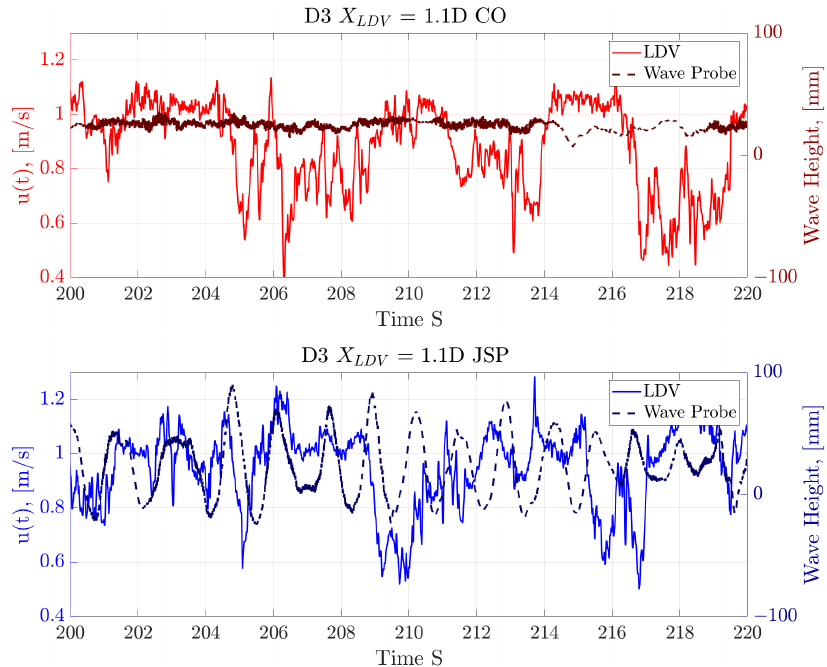
Figure 3. Time series of the stream-wise fluid velocity measured via the LDV and wave height measured via the wave probes. The measurements were made at the rotor plane for the D3 depth with the LDV aligned with the turbine rotor centre. Wave height here is defined as the deviation from the SWL with positive values above the SWL.